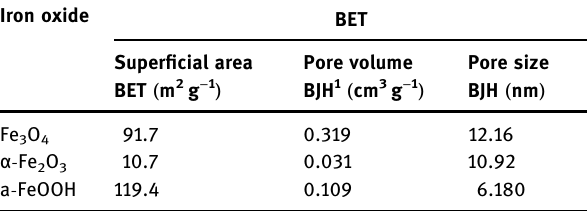
Table 1: Summary of results of surface area ( m 2 g − 1 ) , pore volume ( cm 3 g − 1 ) , and pore size ( nm ) obtained according to the BET model BETIron oxide